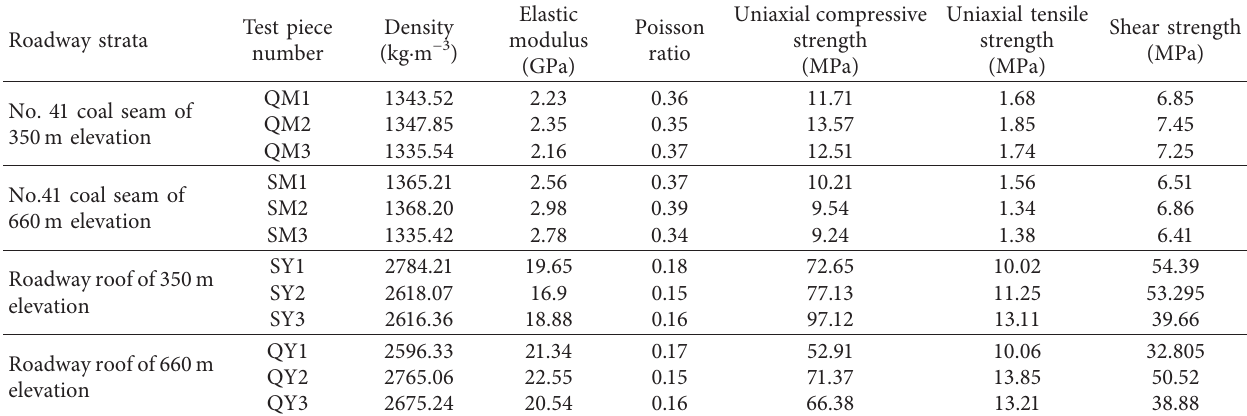
Table 1: Test results of mechanical